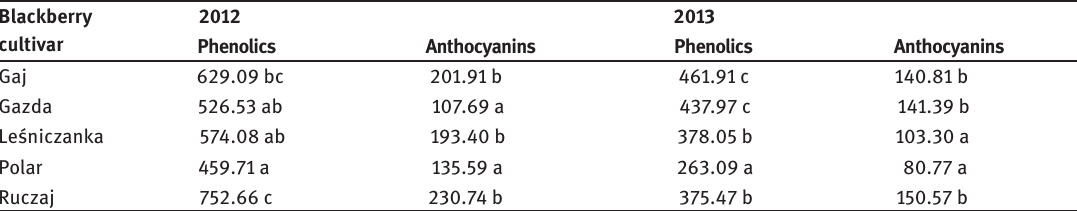
Table 4: Total phenolic and total anthocyanin content of the tested blackberry fruits. Blackberry cultivar